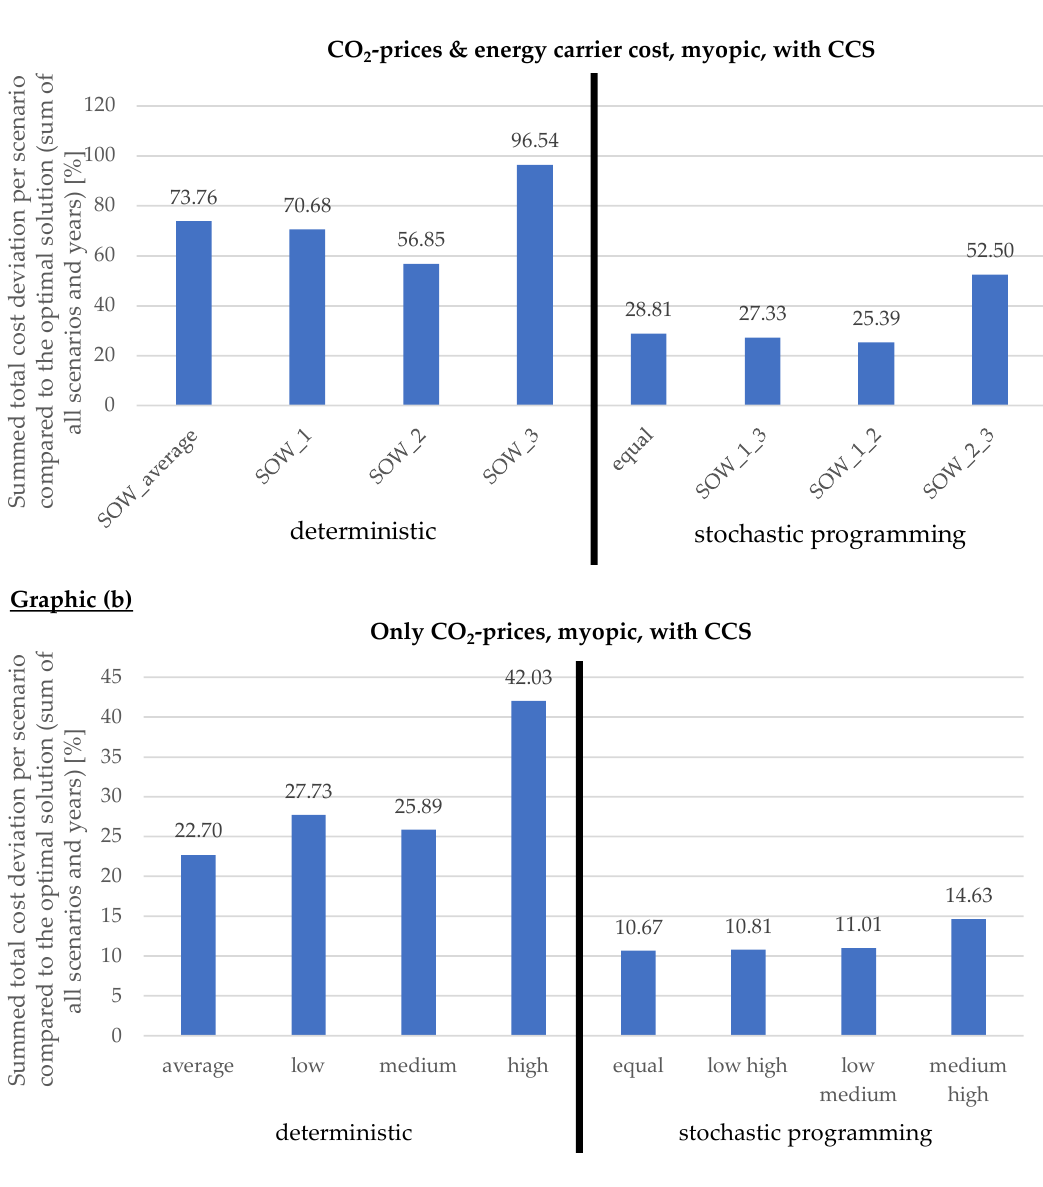
Figure 19. ( a ) STCD per scenario for uncertain CO 2 prices and energy carrier cost (myopic, with CCS); ( b ) STCD per scenario for uncertain CO 2 prices (myopic, with CCS).